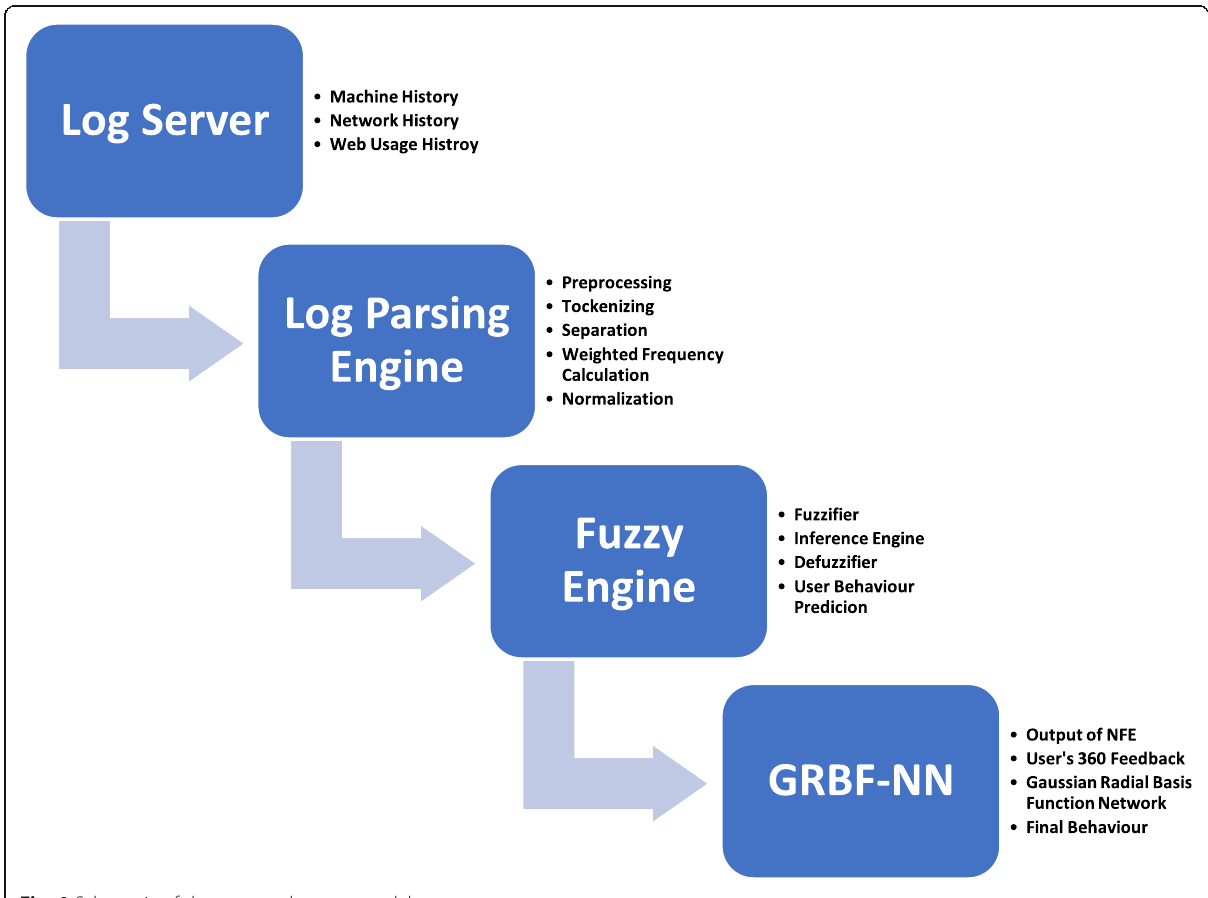
Fig. 1 Schematic of the proposed system